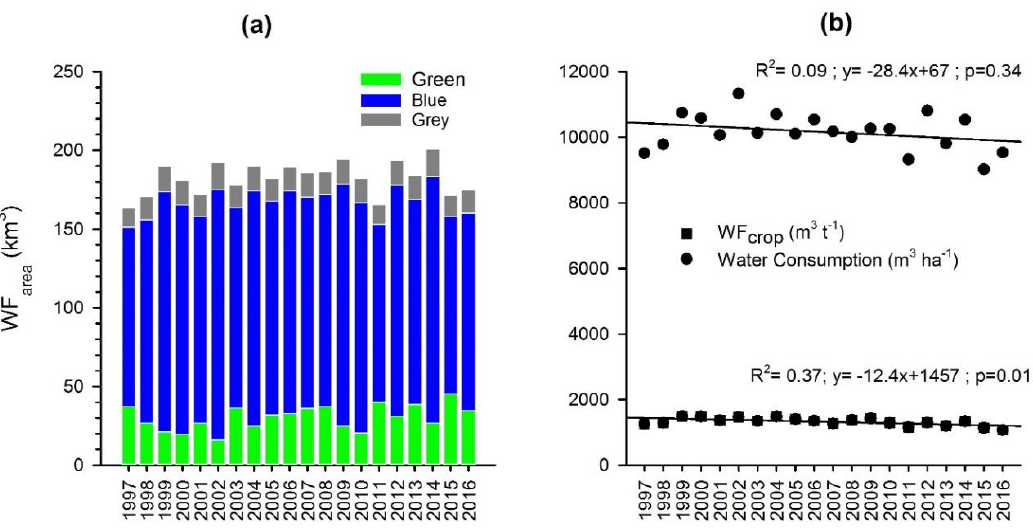
Figure A2. Trends of ( a ) water footprint components; and ( b ) water productivity (m 3 t − 1 ); and water consumption (m 3 ha − 1 ) from 1997–2016. Table A1. Crop coefficients (Kc) used in this study.